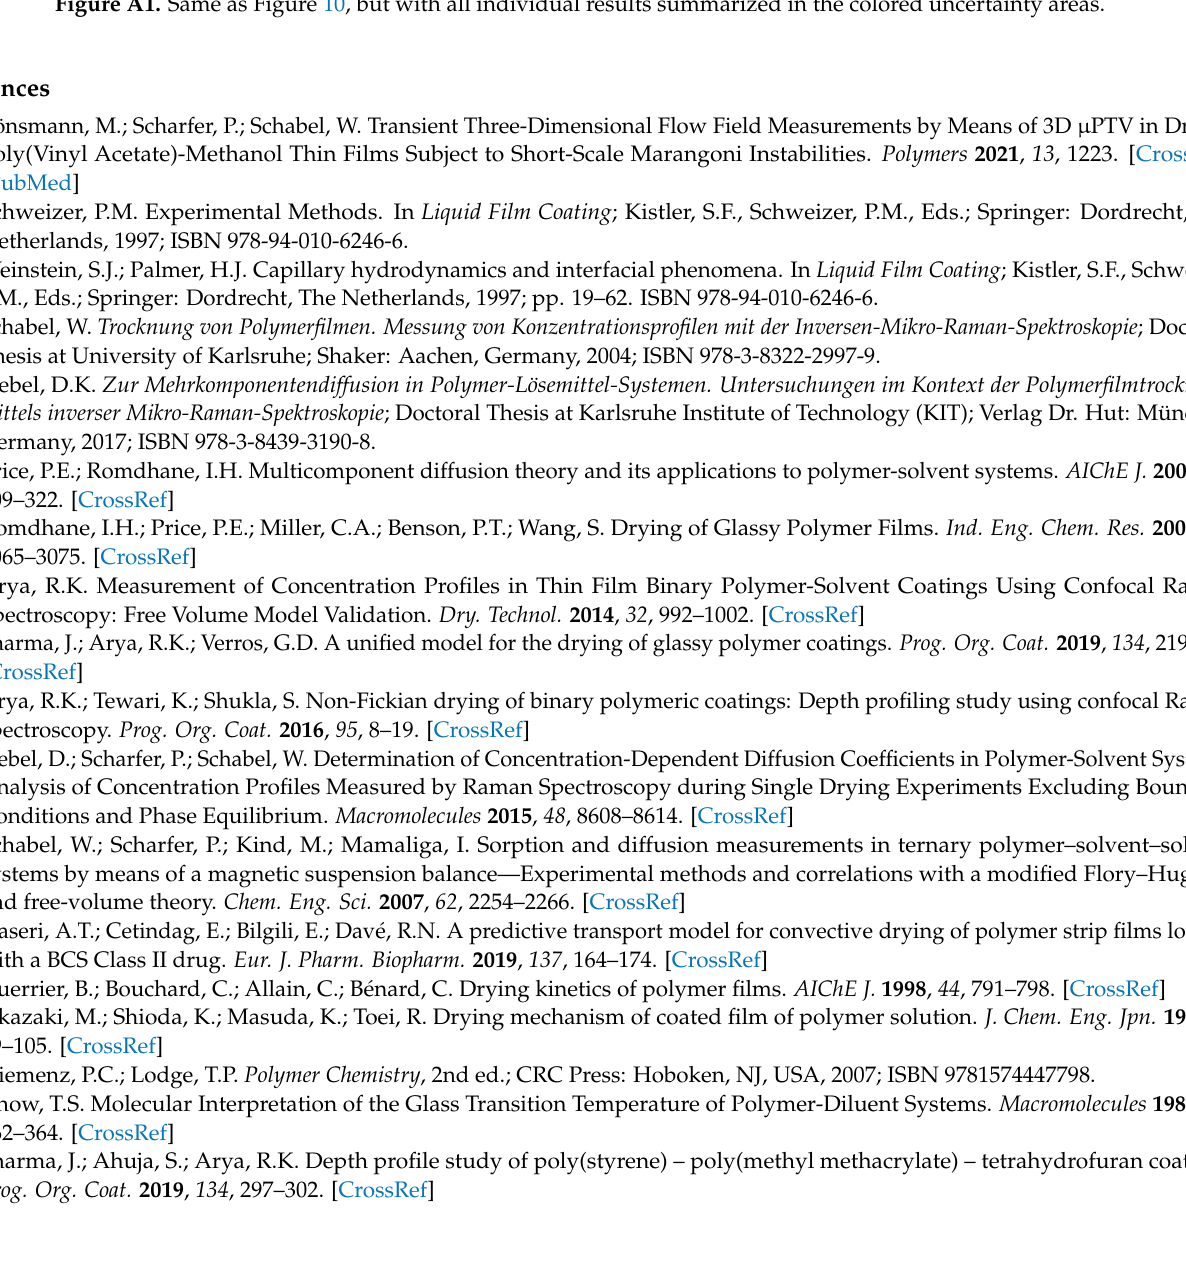
Figure A1. Same as Figure 10, but with all individual results summarized in the colored uncertainty